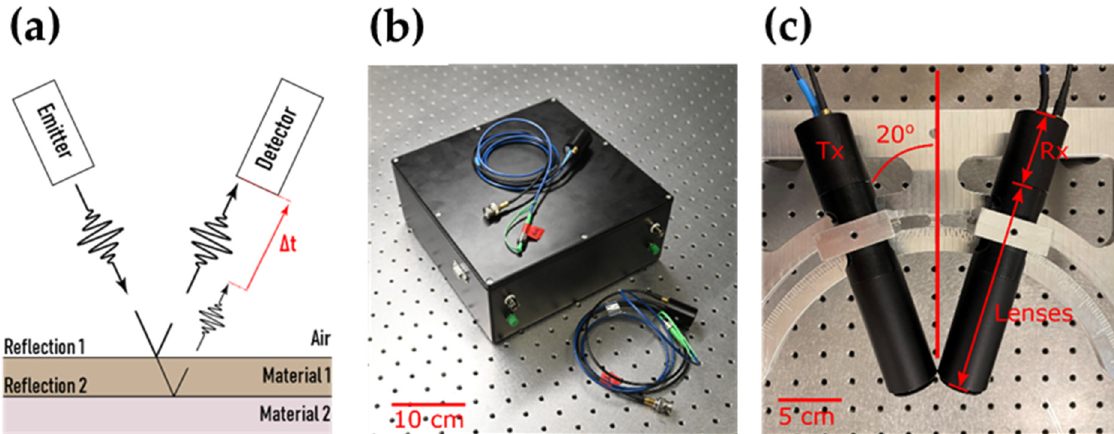
Figure 2. THz TDS principle and setup. ( a ) Outline of the time-of-flight principle where the delay ( ∆ t) between reflections from the top and bottom of Material 1 (e.g., paper) is used to determine the thickness of the material. ( b ) Photograph of the complete THz-DTU measurement system, courtesy of Bax Lindhardt. ( c ) THz emitter (Tx) and detector (Rx) setup with indication of measurement angle.